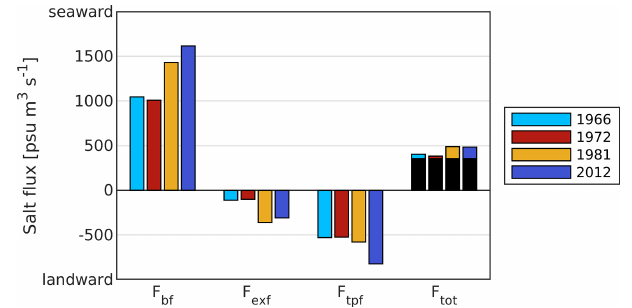
Figure 8. Salt flux through a cross section in the Lower Weser (Weser-km 60), calculated for the period of one spring–neap cycle based on simulations with identical forcing, but different topogra- phy and roughness settings. The barotropic flux F bf , the estuarine exchange flow component F exf , the tidal pumping component F tpf , and the total flux F tot are displayed. The contribution of the river discharge to the total salt flux is highlighted in